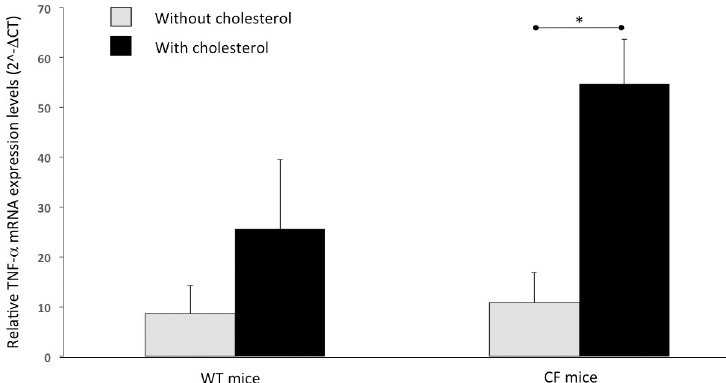
Fig 1. Liver expression of TNF α mRNA normalized on β -2–microglobulin expression levels. Error bars correspond to standard error. Comparisons between two groups were performed by unpaired Student t test. � p < 0.05.